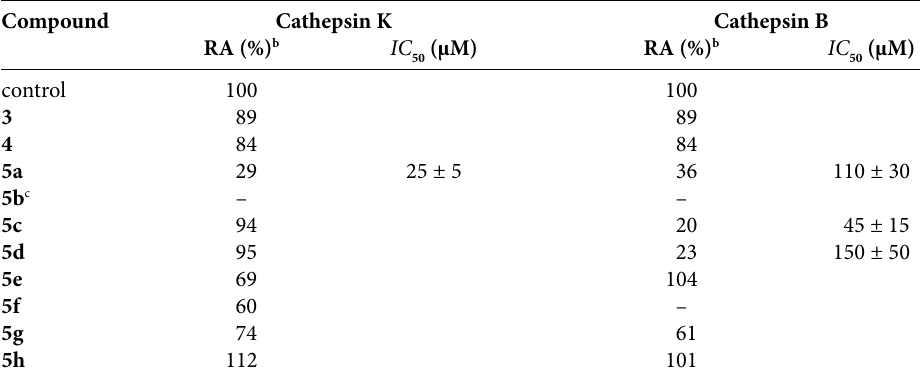
Table 2: Effect of compounds 3 , 4 and 5a – h on the activity of cathepsins K and B. a